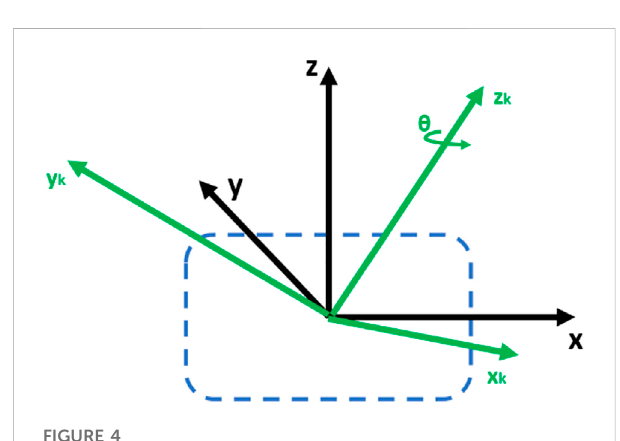
FIGURE 4 Sketch of device and coordinate